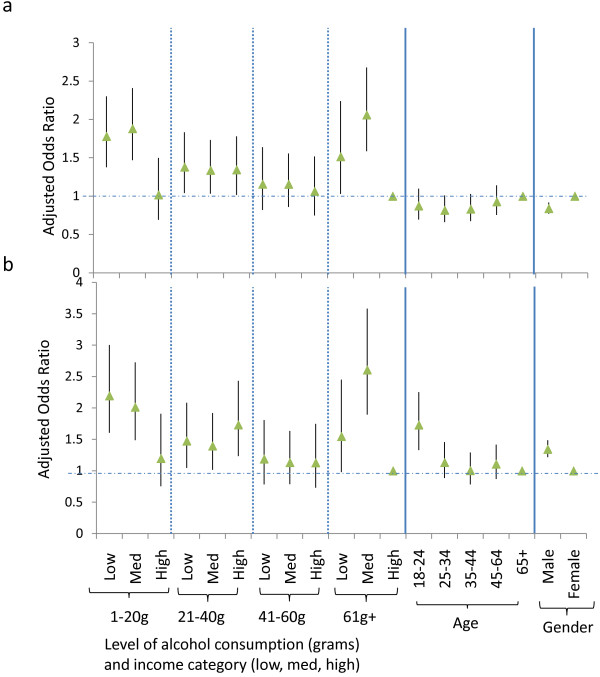
Adjusted odds of price elasticity by gender, drinking category and income. Results of a multinomial logistic regression model (n = 18963), showing the adjusted odds of lower price elasticity (a) and complete price elasticity (b) compared to a reference category of price inelasticity, subdivided by significant variables (age, gender and combined drinking and income categories)